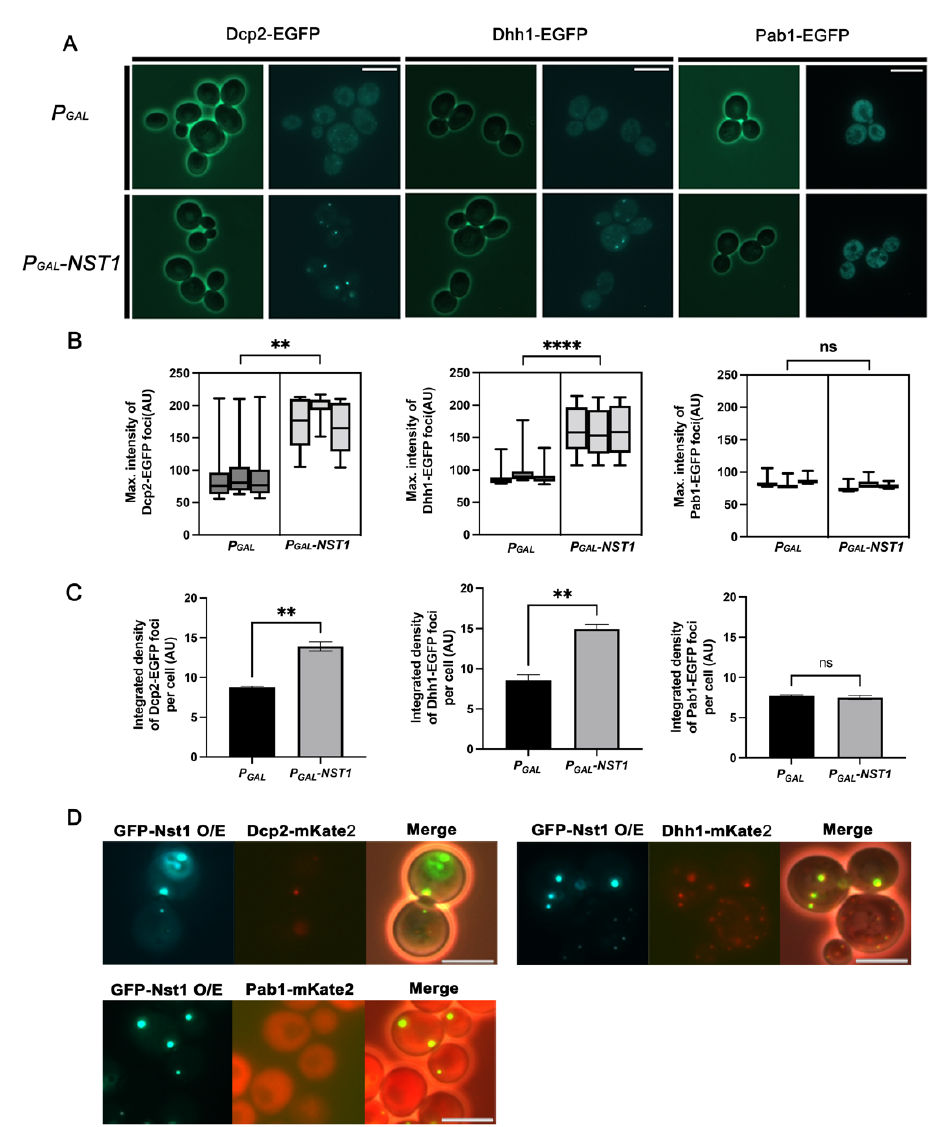
Figure 3. Overexpressed Nst1 drives condensation of PB components by self-condensation. ( A – C ) The wild-type strains, whose chromosomal DCP2 (YSK3485), DHH1 (YSK3484), and PAB1 (YSK3530) were respectively tagged with EGFP , were transformed with pMW20-pGAL and pMW20- pGAL-NST1 . Each strain cultured in a SD-Uracil (2% glucose) medium was transferred to a 2% raf- finose + 0.1% glucose medium for 3 h, and galactose was added to a final 2% concentration. The cells were additionally cultured for 3.5 h for induction of galactose-inducible( gal ) promoter. ( A ) Fluores- cence microscopy of the endogenous EGFP-tagged Dcp2, Dhh1, and Pab1, when Nst1 or vector-only control was overexpressed. Scale bar, 5 μ m. ( B , C ) Measurements of puncta accumulation of the en- dogenous EGFP-tagged Dcp2, Dhh1, and Pab1 in the Nst1-overexpressed wild-type cells of ( A ). More than 300 cells of each strain were monitored for one independent experimental analysis, and every experiment was repeated three times. The segmentation and quantification methods are de- scribed in detail in the Section 4. Error bar shows mean values ± standard error of the mean (SEM). Statistical significance was determined using a Student’s t test (** p < 0.01, **** p < 0.0001). ( B ) Mon- itoring maximum signal intensities of the condensation of PB and SG components by Nst1 overex- pression in ( A ). Maximum pixel intensity values of Dcp2-EGFP, Dhh1-EGFP, and Pab1-EGFP puncta of vector-only control ( P GAL ) and Nst1-overexpressed ( P GAL -NST1 ) cells were measured and analyzed using FIJI ImageJ. ( C ) Quantitative analysis of Dcp2-EGFP, Dhh1-EGFP, and Pab1-EGFP puncta per cell by Nst1 overexpression in ( A ). Total integrated density of each Dcp2-EGFP, Dhh1- EGFP, and Pab1-EGFP segmented puncta in vector-only control and Nst1-overexpressed cells was determined using FIJI ImageJ. ( D ) Wild-type strains expressing endogenous Dcp2-mKate2